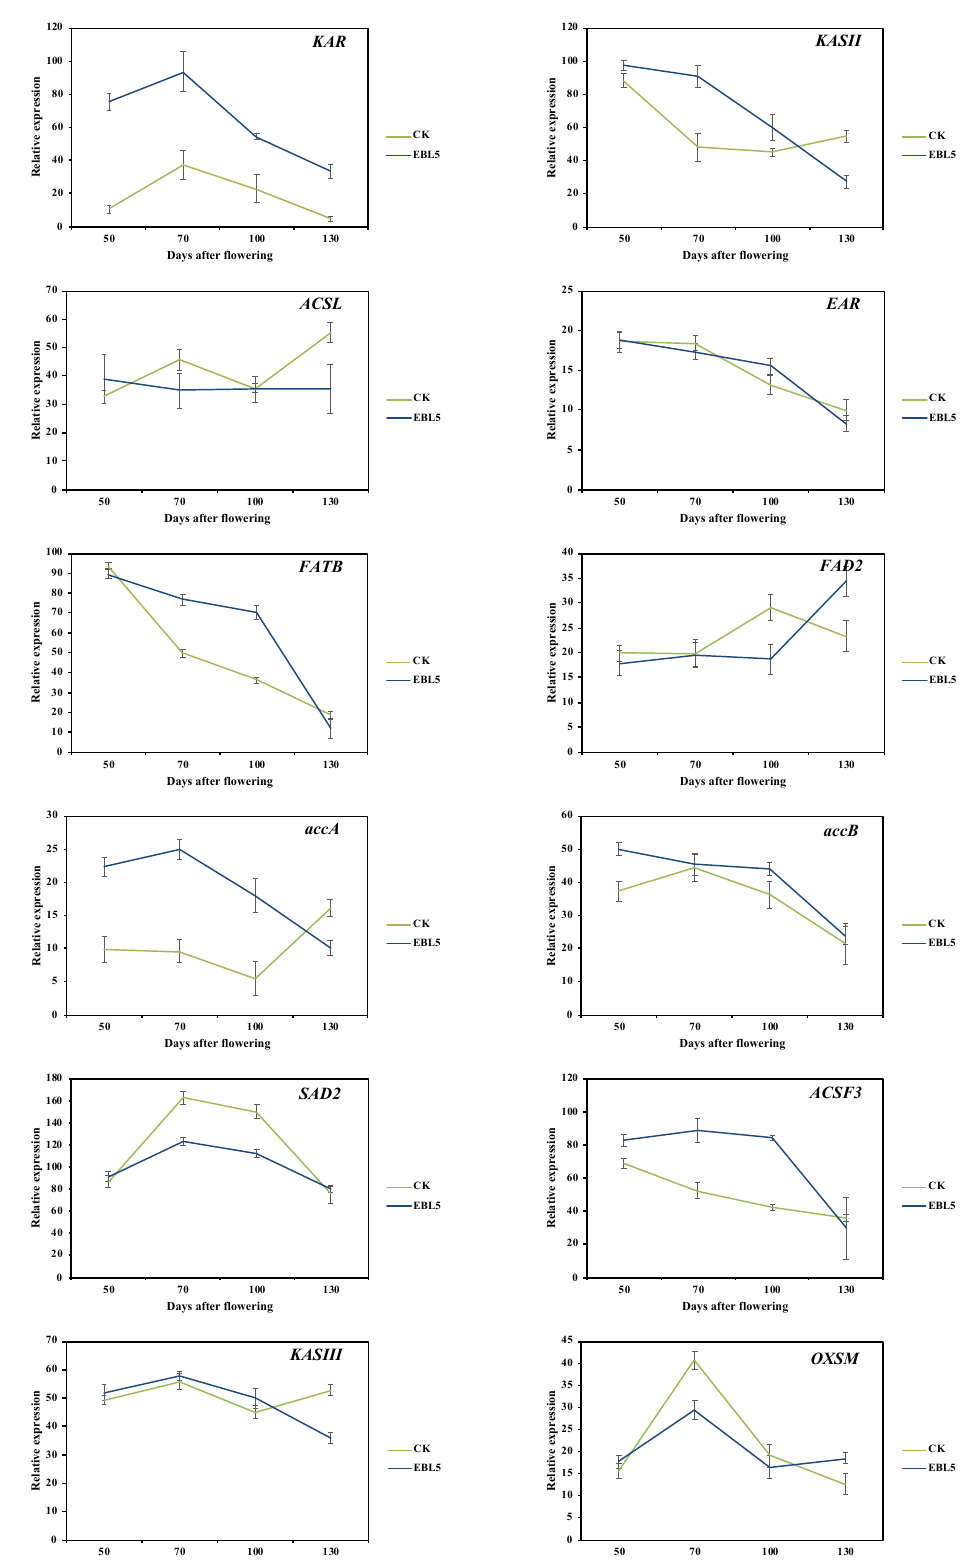
Figure 9. Relative expression levels of FA biosynthesis-related genes at 50, 70, 100, and 130 DAF. Data were shown as mean ± SD of three biological replicates; gene expression levels at 50 DAF were used as reference.